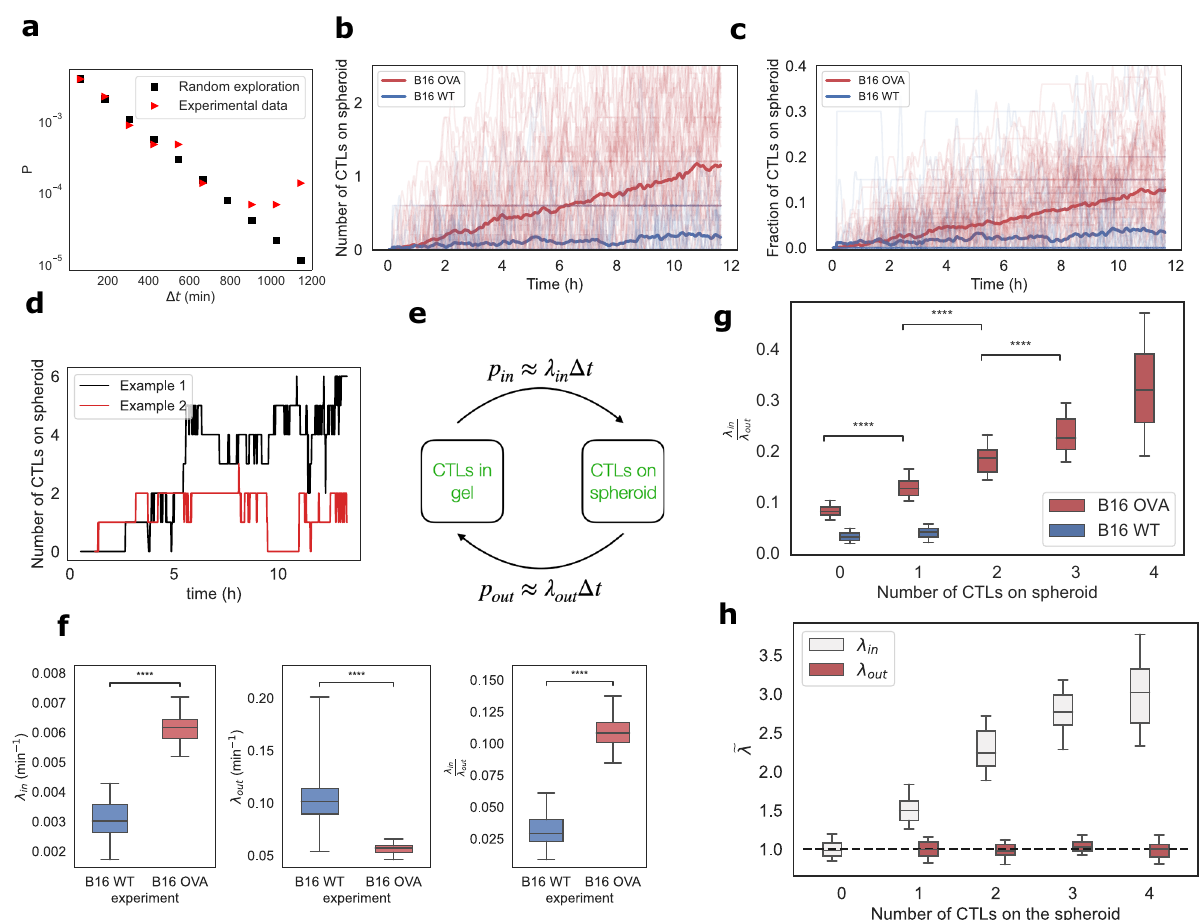
Fig. 3 CTL accumulation is enhanced by a positive feedback-loop after fi rst contact. a Experimental distribution of fi rst CTL-spheroid contact times and theoretical distribution for randomly migrating CTLs. b Number of CTLs detected on each spheroid and c the fraction per droplet as a function of time. Each thin line represents a single tracked spheroid, in bold is the averaged value. In red is the accumulation for B16-OVA spheroids and in blue for B16 WT spheroids [84 individual B16-OVA spheroids and 81 B16 WT spheroids tracked]. d Number of CTLs as a function of time on two representative spheroids showing the detection of attachment/detachment events. e Schematic of the stochastic accumulation model: CTLs can switch from the gel to the spheroid with different probabilities. p in ( Δ t ) (conv. p out ( Δ t )) is the probability for a cell to attach to (conv. detach from) the spheroid during a time interval Δ t . Counting attachment and detachment events in the experiments allow us to infer the rates λ in and λ out . f Estimates for the attachment rates ( λ in ), detachment rates ( λ out ), and af fi nity ratio ( λ in / λ out ) for B16-WT (blue) and B16-OVA (red) cells. The box plots are obtained by using a bootstrapping method with 50 repetitions as described in the methods (respective p -values of 7 × 10 − 18 , 1.2 × 10 − 16 , and 7 × 10 − 18 ). g The af fi nity ratio as a function of the number of CTLs detected on the spheroid for B16 WT and B16 Ova spheroids (respective p-values of 6 × 10 − 9 , 3 × 10 − 15 , and 1.3 × 10 − 13 ). h Normalized attachment rate λ in (white) and detachment rate λ out (red) as a function of the number of CTLs attached to the spheroid. λ in and λ out are normalized by their mean values for 0 and 1 CTL on the spheroid, respectively. Source data are provided as a Source data fi